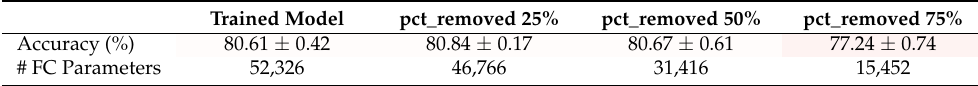
Table 9. Results of decomposing fully connected layers of ResNet-18 with 3 different compression levels. Mean and standard deviation of accuracy over 3 rounds are reported. The darker the shade of red, the further the accuracy is from the